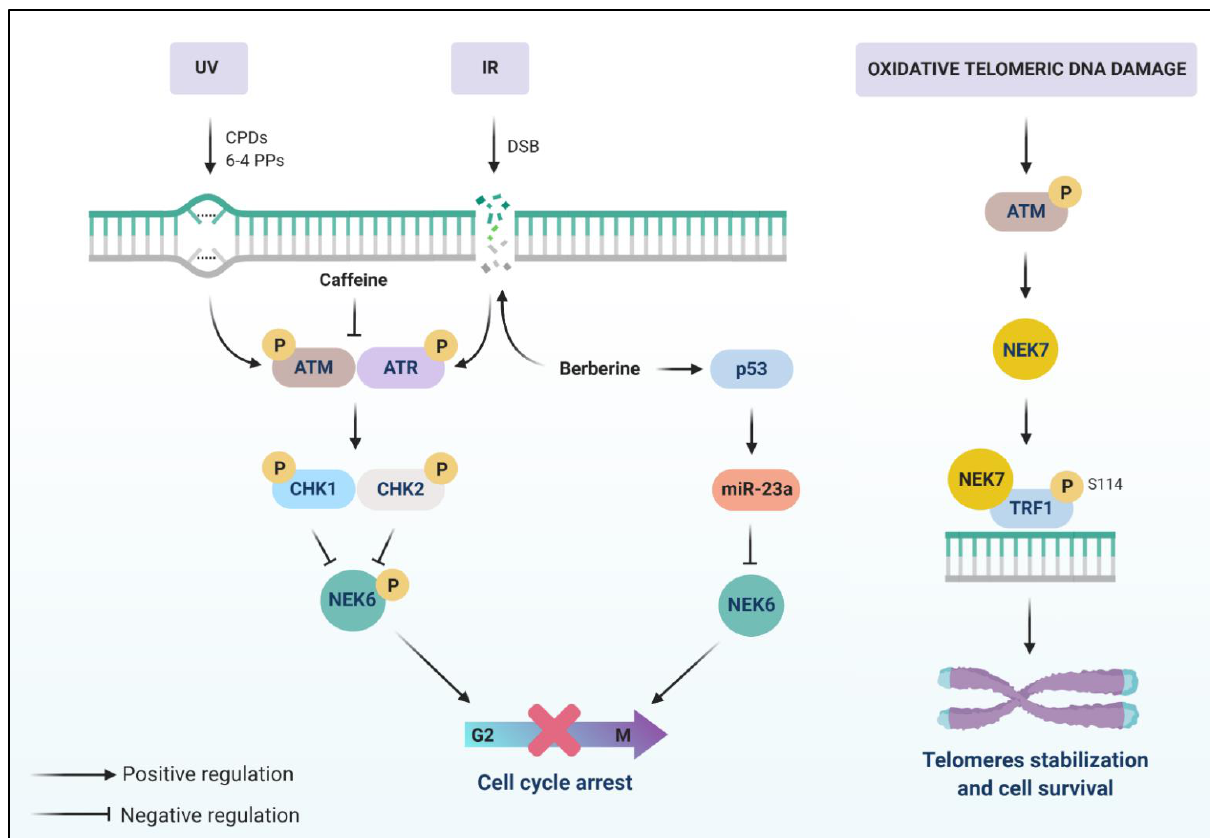
Figure 3. The possible involvement of NEK6 and NEK7 in DDR. NEK6 kinase activity is inhibited by ATM/ATR-Chk1/Chk2 caffeine-sensitive signaling pathway after DSBs induced by IR and UV treatment. NEK6 kinase activity inhibition by DDR is necessary for G2/M arrest. NEK6 is repressed by miR-23a, which is induced by berberine, a genotoxin that increases the accumulation of DSBs, in a p53-dependent manner. NEK7 is related to a protective function of telomeres in response to oxidative DNA damage. ATM activation mediates the function of NEK7 in telomeres. NEK7 is recruited to the telomeres and binds and phosphorylates TRF1 in S114, preventing its degradation. The integrity of telomeres is linked to the stability of TRF1.